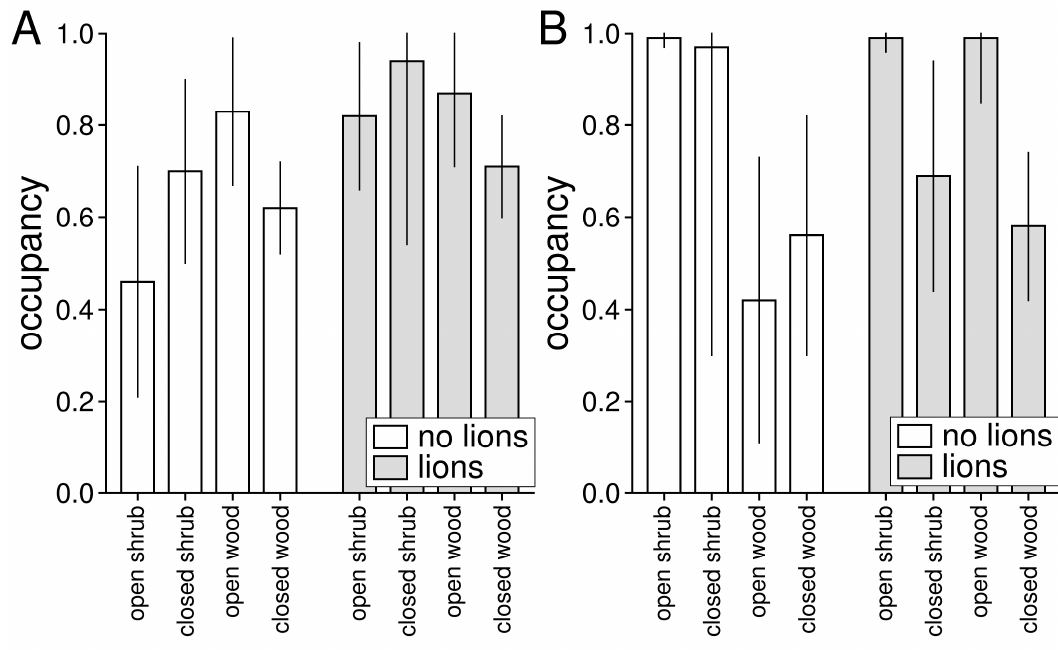
Figure 3. Estimated as probability of occupancy of brown hyaenas ( A ) and leopards ( B ) in four broad habitat classes in a reserve without (Lapalala) and with (Welgevonden) lions. Occupancy estimates were estimated from single species occupancy models based on camera trapping